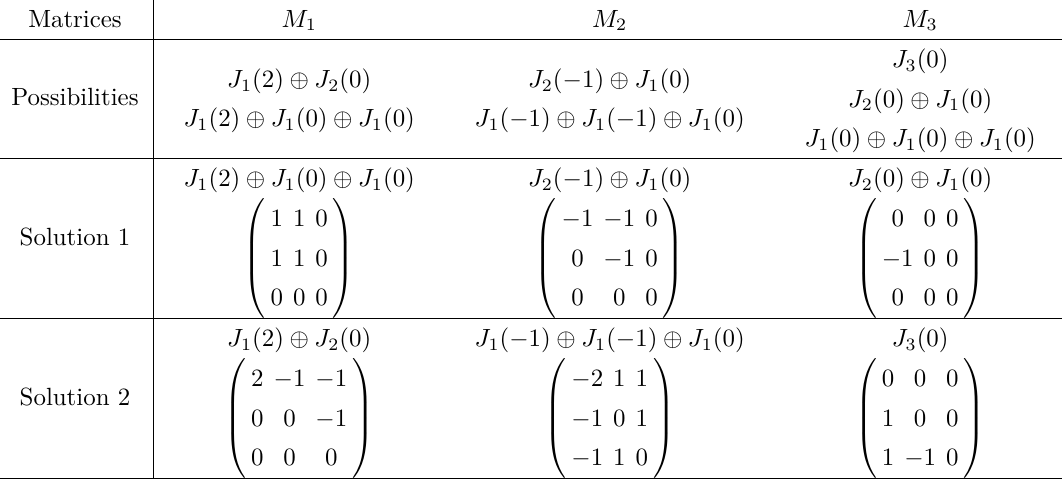
Table 1 . Solutions for the FI deformations (3.10). The columns are labelled by the 3 × 3 meson matrices, one for each leg in the quiver. The possibilities are the possible Jordan types compatible with the FI constraints. Then we show the two extremal solutions in terms of Jordan forms, and with a choice of